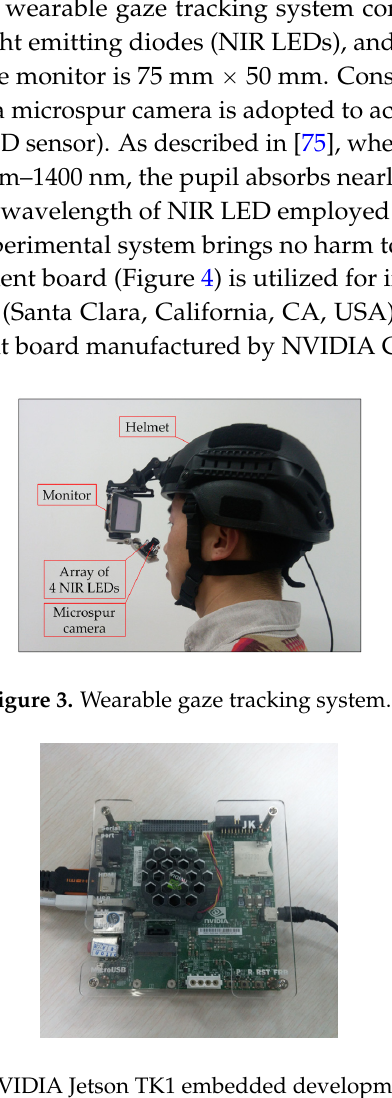
( f ) Figure 5. Pupil detection: ( a ) original eye image; ( b ) eye binary image utilizing improved Otsu optimal threshold; ( c ) results of opening ‐ and ‐ closing operation; ( d ) rough location of pupil region; ( e ) extraction of pupil boundary points; ( f ) pupil contour fitting. 3.2.2. Glint Detection For the reason that the glint’s illumination intensity is suitable for Gaussian distribution, Gaussian function deformation solved by improved total least squares [77] is utilized to calculate the glint center. The detection result of glint is shown in Figure 6. ( a ) ( b ) Figure 6. Glint detection: ( a ) rough location of glint; ( b ) glint detection results.